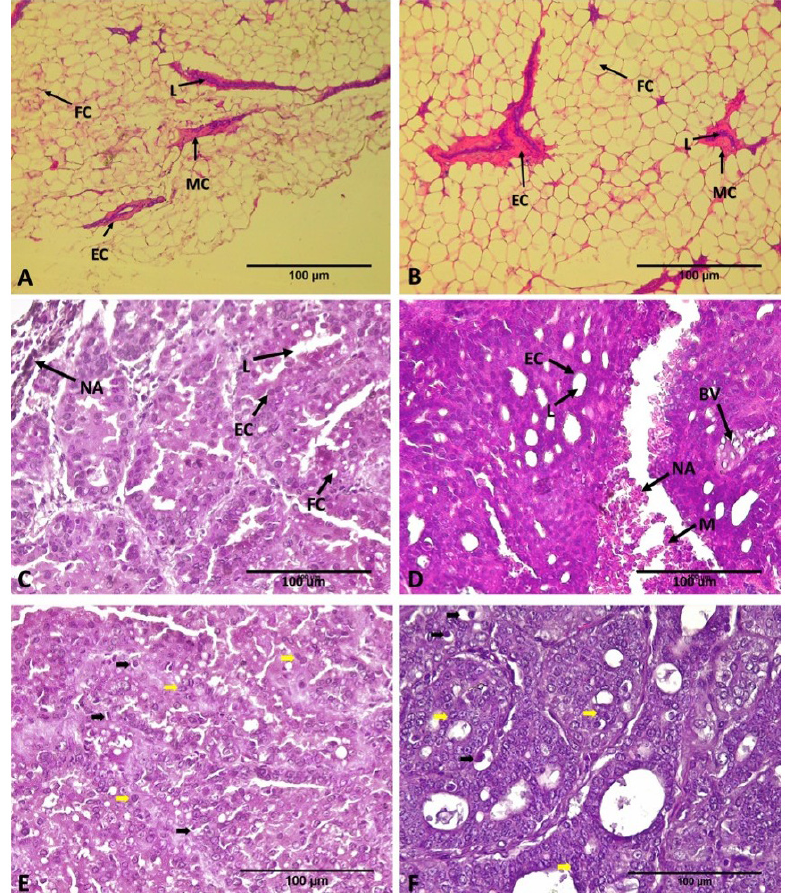
Figure 2. Histological sections of the mammary gland and DMBA-induced rat breast adenocarcinoma after treatment with ECCT exposure. ( A and B ) There is no morphological change both on mammary gland tissue of none DMBA-induced rat non-EF therapy (NINT; A ), and with EF therapy (NIT; B ). Hematoxylin and eosin staining, magnification 100x. ( C and D ) In contrast, adenocarcinoma breast tissue of DMBA induced rat non-EF therapy (INT; C ) shows more massive tumor cells and fewer lumens than the tumor section with EF therapy (IT; D ). Hematoxylin and eosin staining, magnification 400x. ( E and F ) Mitotic figure (black arrow) and apoptotic figure (yellow arrow) on breast tumor tissues of INT and IT group, respectively. FC= Fat Cells, L=Lumens, EC=Epithelial Cells, M= Myoepithelial Cell, NA= Necrotic Area, BV= Blood